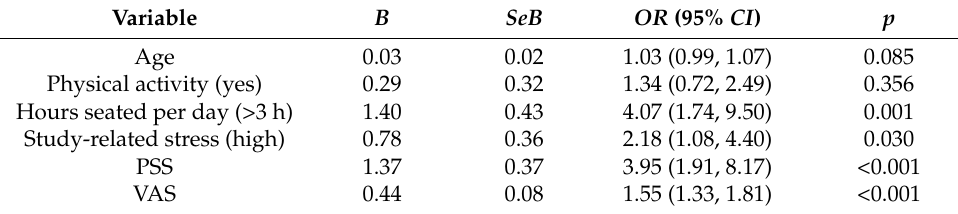
Table 3. Logistic regression model for NDI ( ≥ 15) with background variables, physical habits, stress, and pain, ( N =